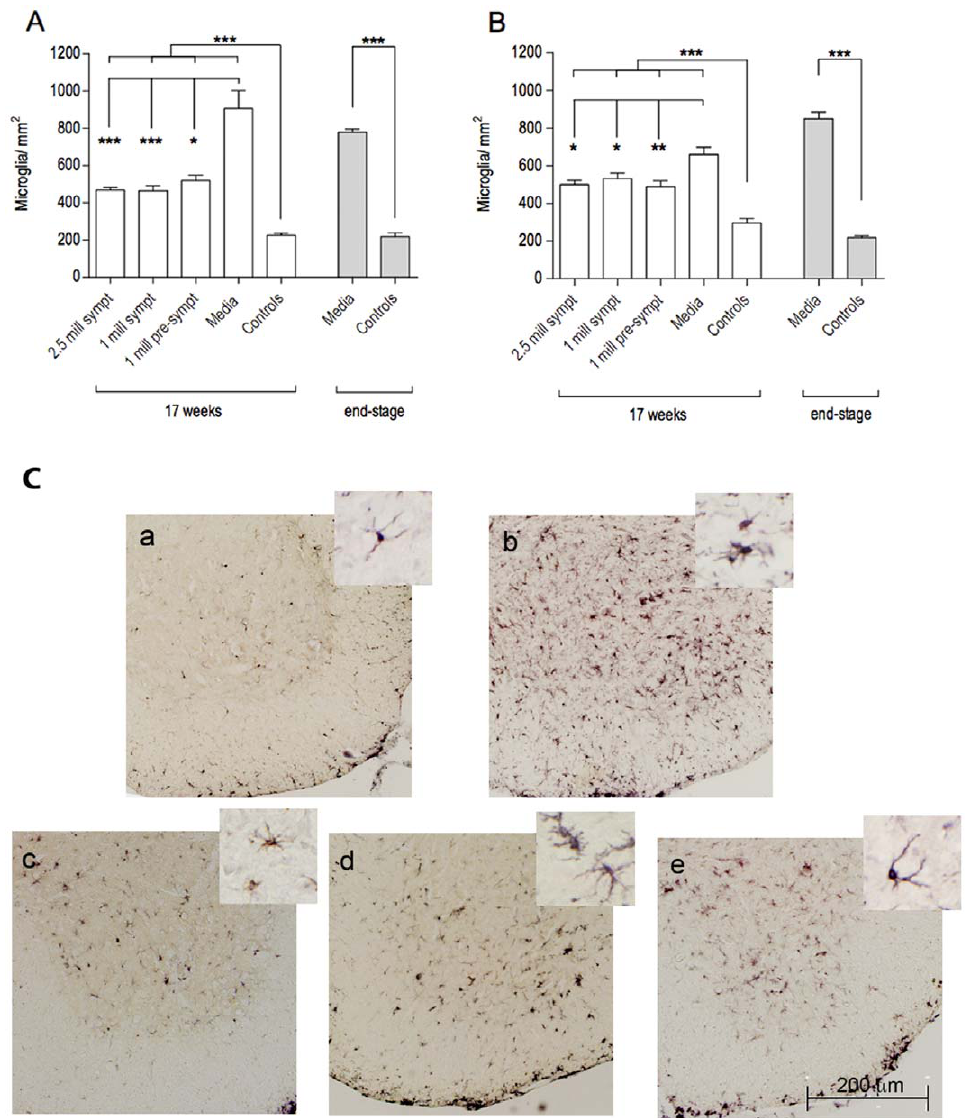
Figure 6. Characteristics of microglial cells in the spinal cords of G93A mice. Microglial densities were measured in the cervical ( A ) and lumbar ( B ) ventral horns of G93A mice at 17 weeks of age and at end-stage of disease. Microglial densities were significantly (p , 0.001) higher in Media-injected mice ( Gr 4 ) compared to control mice ( Gr 5 ) of the same ages. MNC hUCB cell administrations significantly (p , 0.001) decreased the number of microglia in the spinal cord of G93A mice compared to Media mice. No significant differences were detected between the cell-treated groups. *p , 0.05, **p , 0.01, ***p , 0.001. ( C ) Immunohistochemical staining of microglia in the lumbar spinal cord at 17 weeks of age. Microglial cells stained for anti-Iba-1 antibody were sparse in controls ( a ) and microgliosis was noted in Media-treated animals ( b ). MNC hUCB cells decreased microglial density in mice from Gr 1 ( c ), Gr 2 ( d ), and Gr 3 ( e ). Morphological analysis of microglial cells determined numerous activated cells with large cell bodies and short processes in Media-injected mice, whereas ramified microglia were mostly observed in cell-treated animals, particularly in Gr 1 and Gr 3 mice and controls (inserts in a–e). Scale bar: a–e is 200 m m; in a–e inserts is 25 m m.